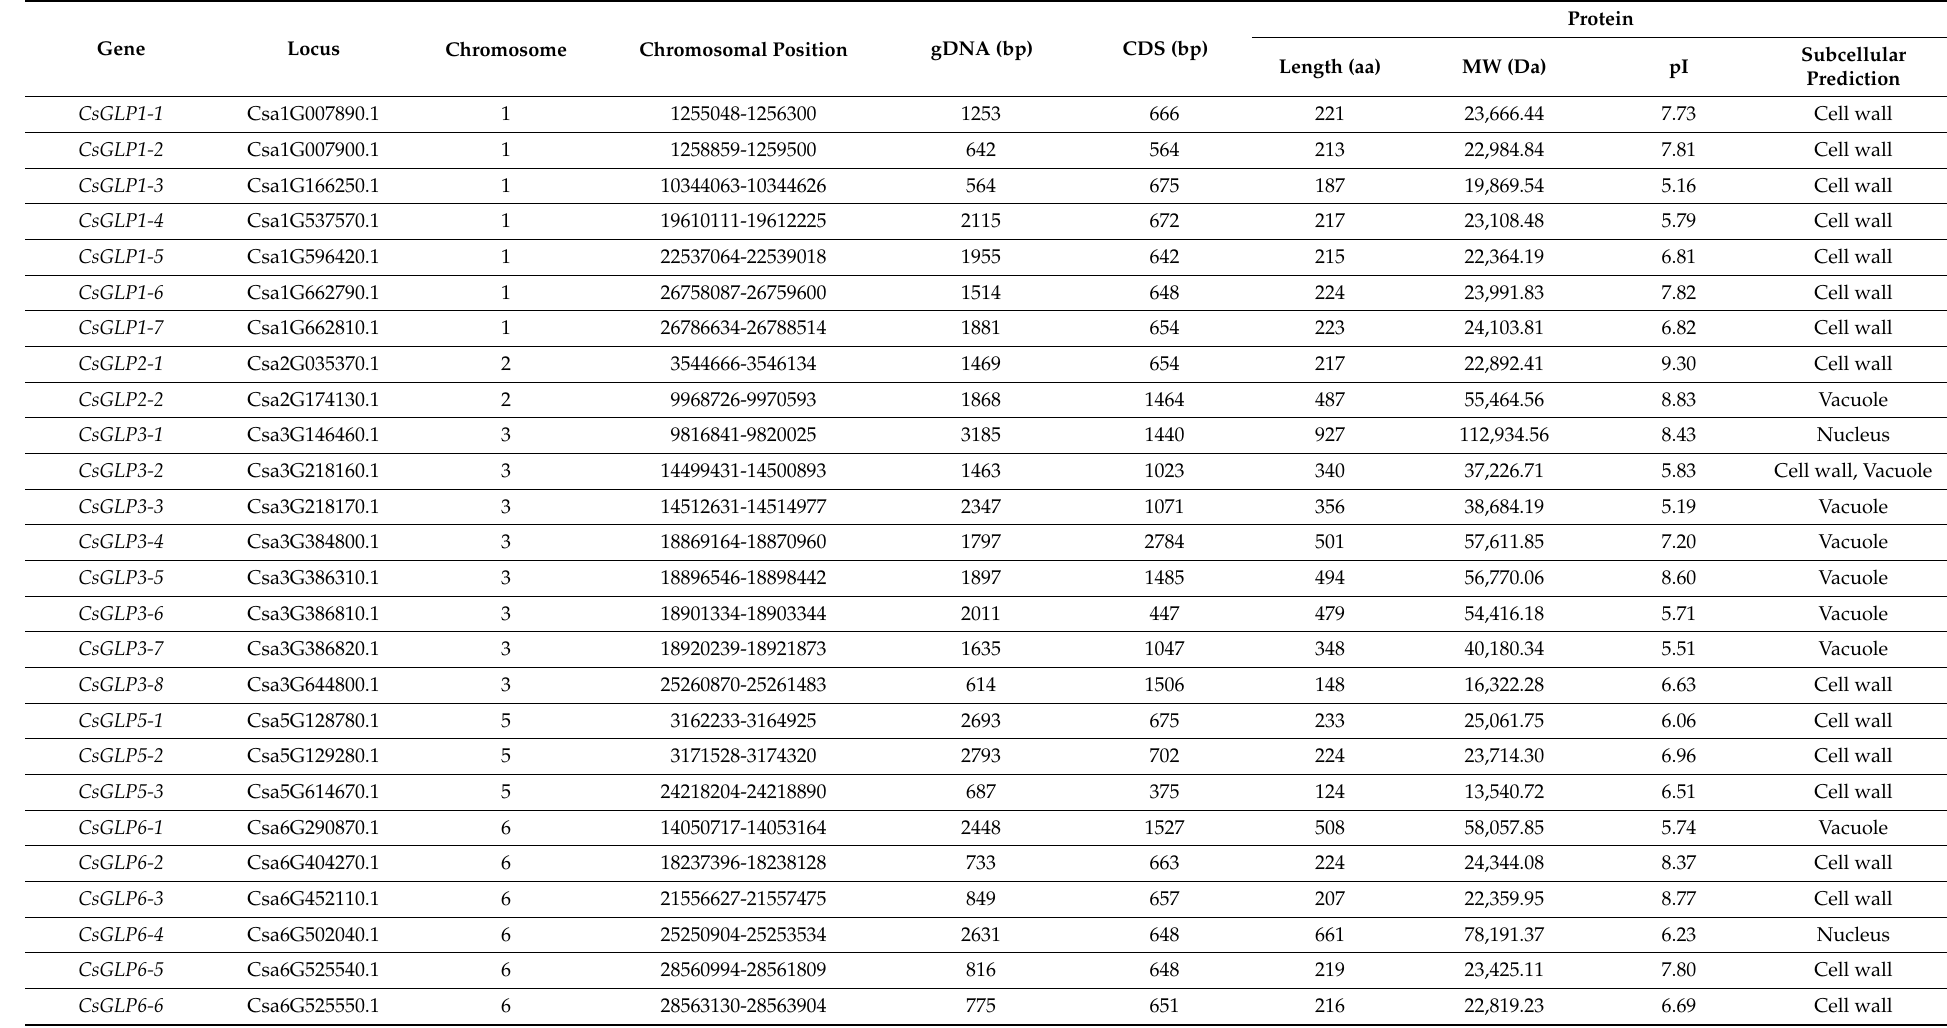
Table 1. Identification and characterization of GLP family genes in